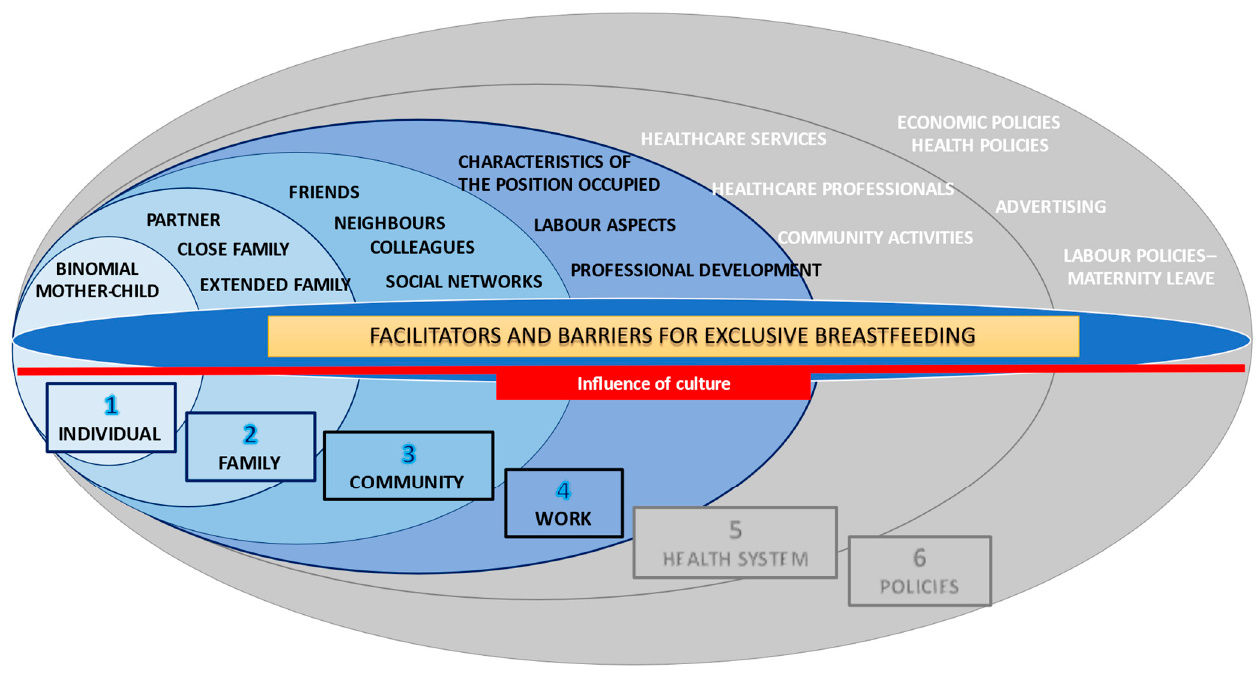
Figure 1. Barriers and facilitators for exclusive breastfeeding in women ′ s biopsychosocial spheres according to primary care midwives in Tenerife (Canary Islands, Spain). Authors: Seila Llorente-Pulido; Estefanía Custodio; María R. López- Gimenez; Belén Sanz-Barbero; Laura Otero-García. Article Type: Original Research. Adaptation of Bronfenbrenner’s Eco- logical Model.